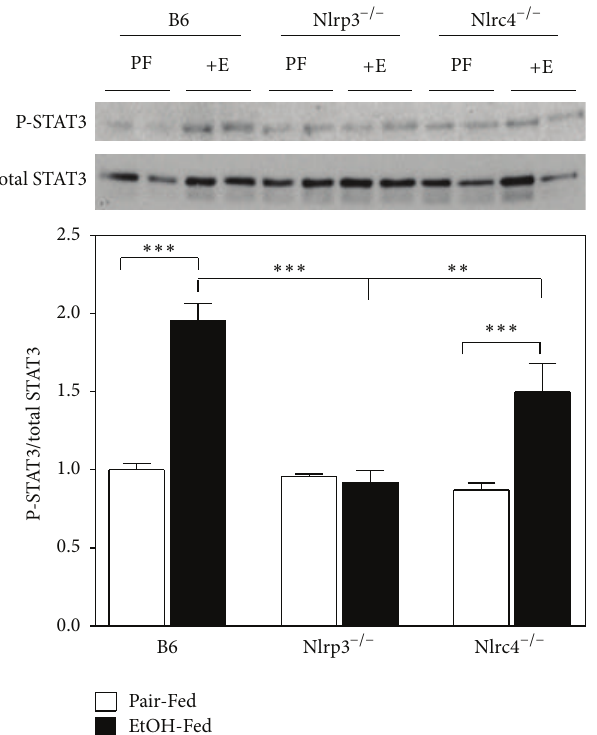
Figure 9: Decreased phosphorylation of STAT3 in the liver in Nlrp 3 −/− and Nlrc 4 −/− mice. Protein was isolated from livers of C57BL/6J (B6), Nlrp 3 −/− , and Nlrc 4 −/− mice fed Lieber-DeCarli ethanol-containing diet (EtOH-Fed) or pair-fed controls (Pair-Fed). Expression of hepatic total STAT3 and phosphorylated STAT3 was measured by western blot analysis. In the graph, densitometric scans of western blots were performed and analyzed. The values are the means ± SEM. The phosphorylated STAT3 was normalized by total STAT3. Values represent the mean ± SEM with ∗∗ 𝑃 < 0.05 , ∗∗∗ 𝑃 < 0.001 by Student’s 𝑡 -test for 𝑛 = 4 –6 mice per